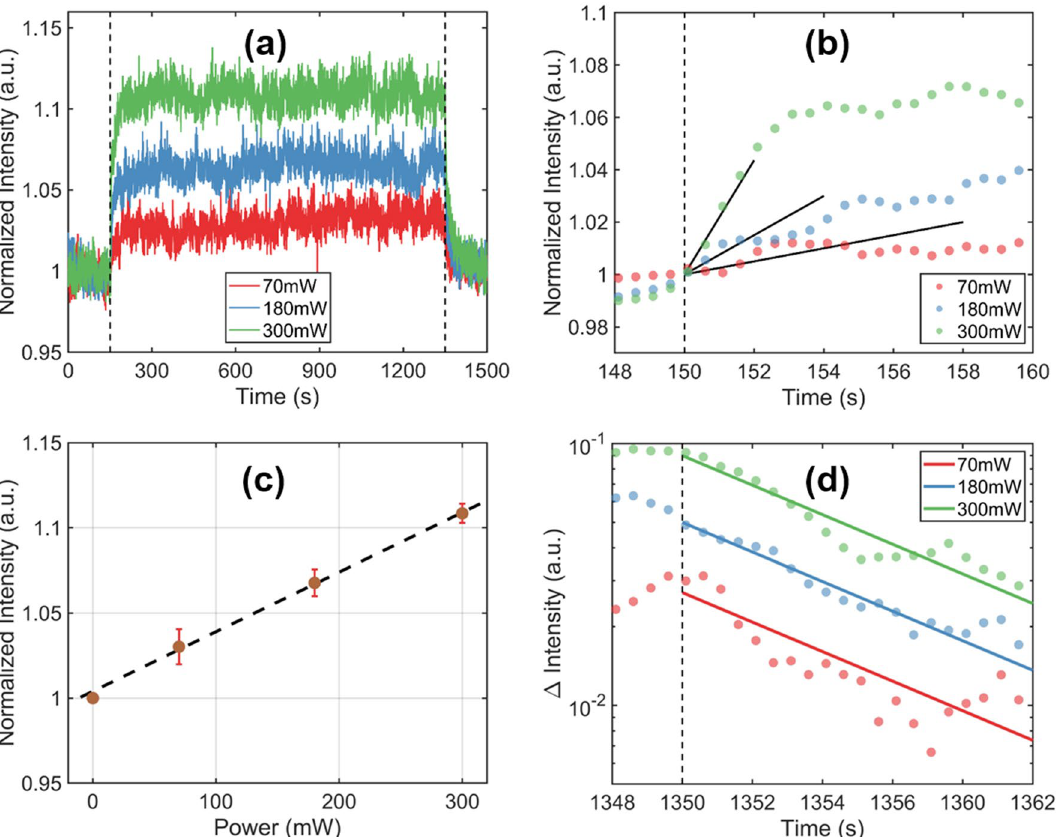
Figure 4. ( a ) Evolution of normalized transmittance for different power of the vortex beam as indicated. ( b ) Immediately after the field is applied, the transmitted intensity increases linearly in time (see text). ( c ) Normalized values of maximum transmitted intensity as function of applied power. ( d ) The rate of transmittance decrease after the external field is turned off at t = 1350